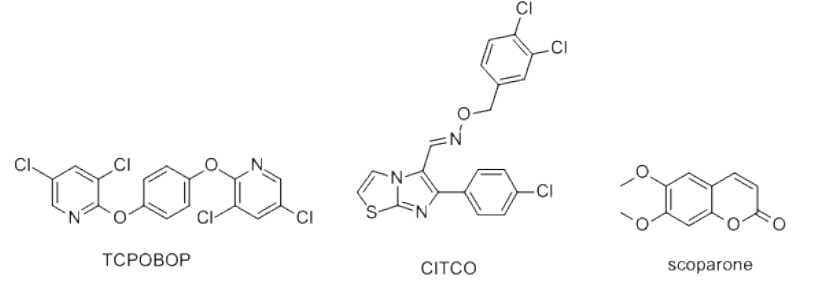
Figure 1. Structures of CAR direct activators. TCPOBOP is a mouse CAR direct activator. CITCO is a human CAR direct activator.